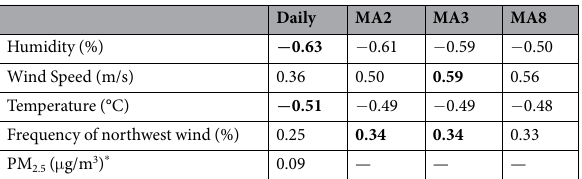
— — — Table 1. Correlation coefficients between diversity of airborne bacterial communities and environmental/ meteorological factors. Note: MA2, MA3, and MA8 represent the 2-, 3-, and 8-day moving averages, respectively. * PM 2.5 concentrations were measured on a sampling day, thus no moving average was